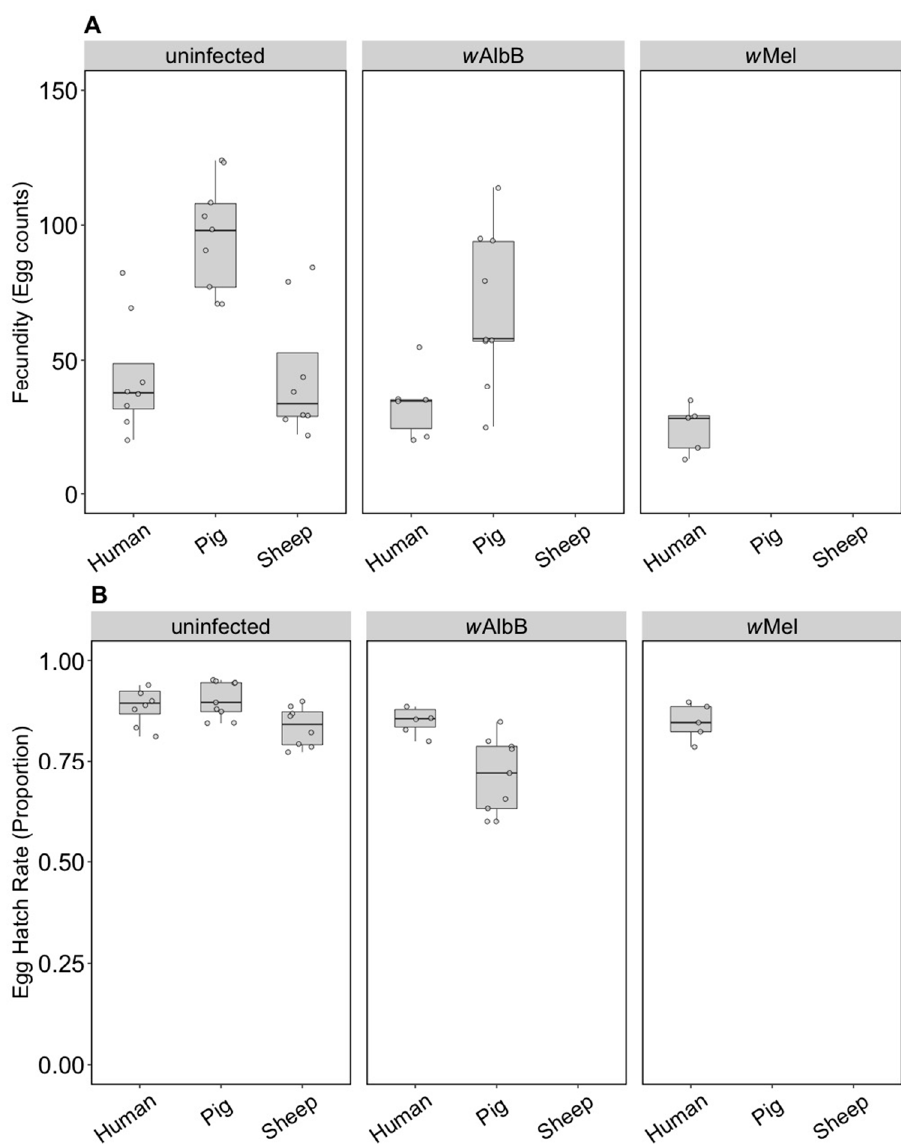
Figure 4. Comparison of fecundity and egg hatch rates across infection types (uninfected, w Mel, w AlbB) and different blood sources (human, pig, sheep) of F4 selected groups. ( A ) Fecundity (egg counts); ( B ) egg hatch rate (proportion). Each dot embodies the egg count and egg hatch rate of an individual female with 5–9 females tested per treatment. The boxplots represent the first to the third quartiles around the median (horizontal grey line) and the vertical bars represent the 1.5 interquartile of the lower and upper quartiles.